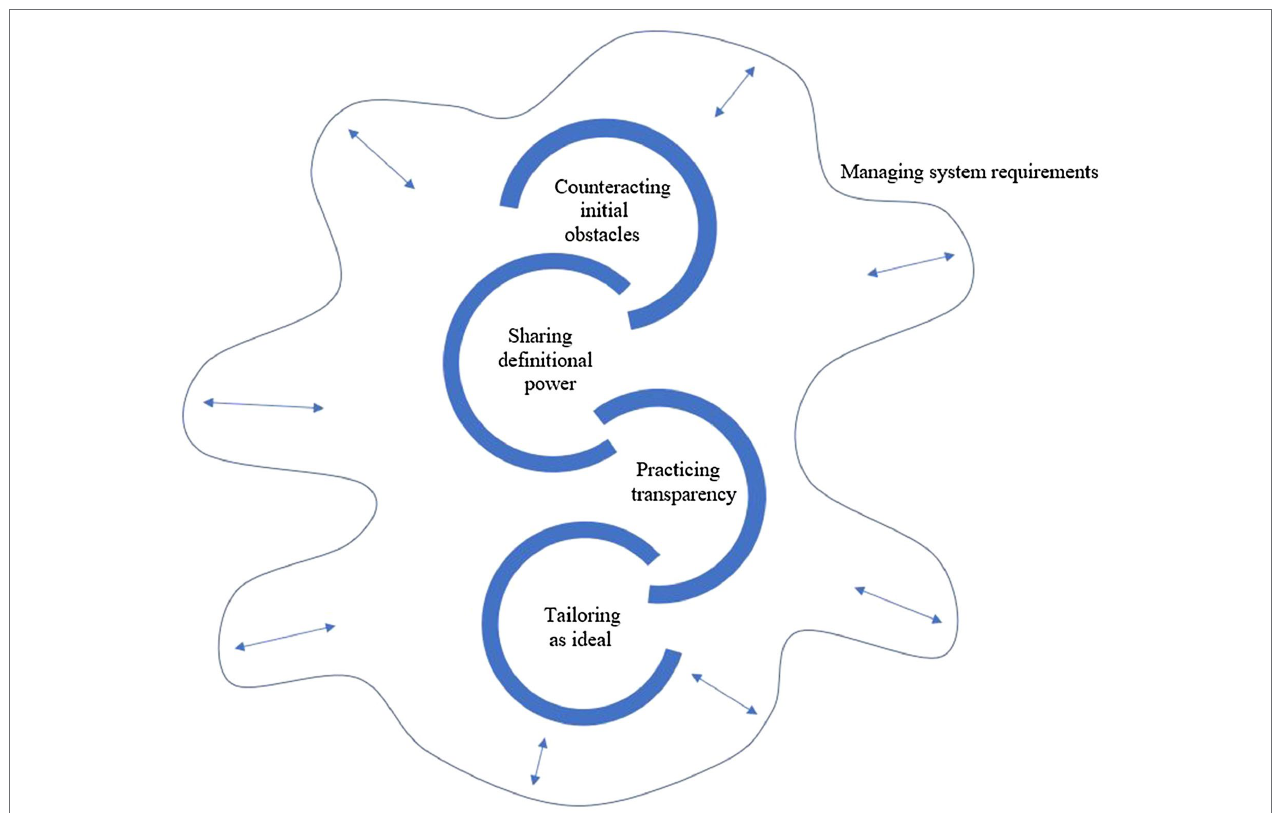
FIGURE 1 | Illustration of how theme 1, Managing system requirements , influence available therapeutic room to work with processes facilitating client